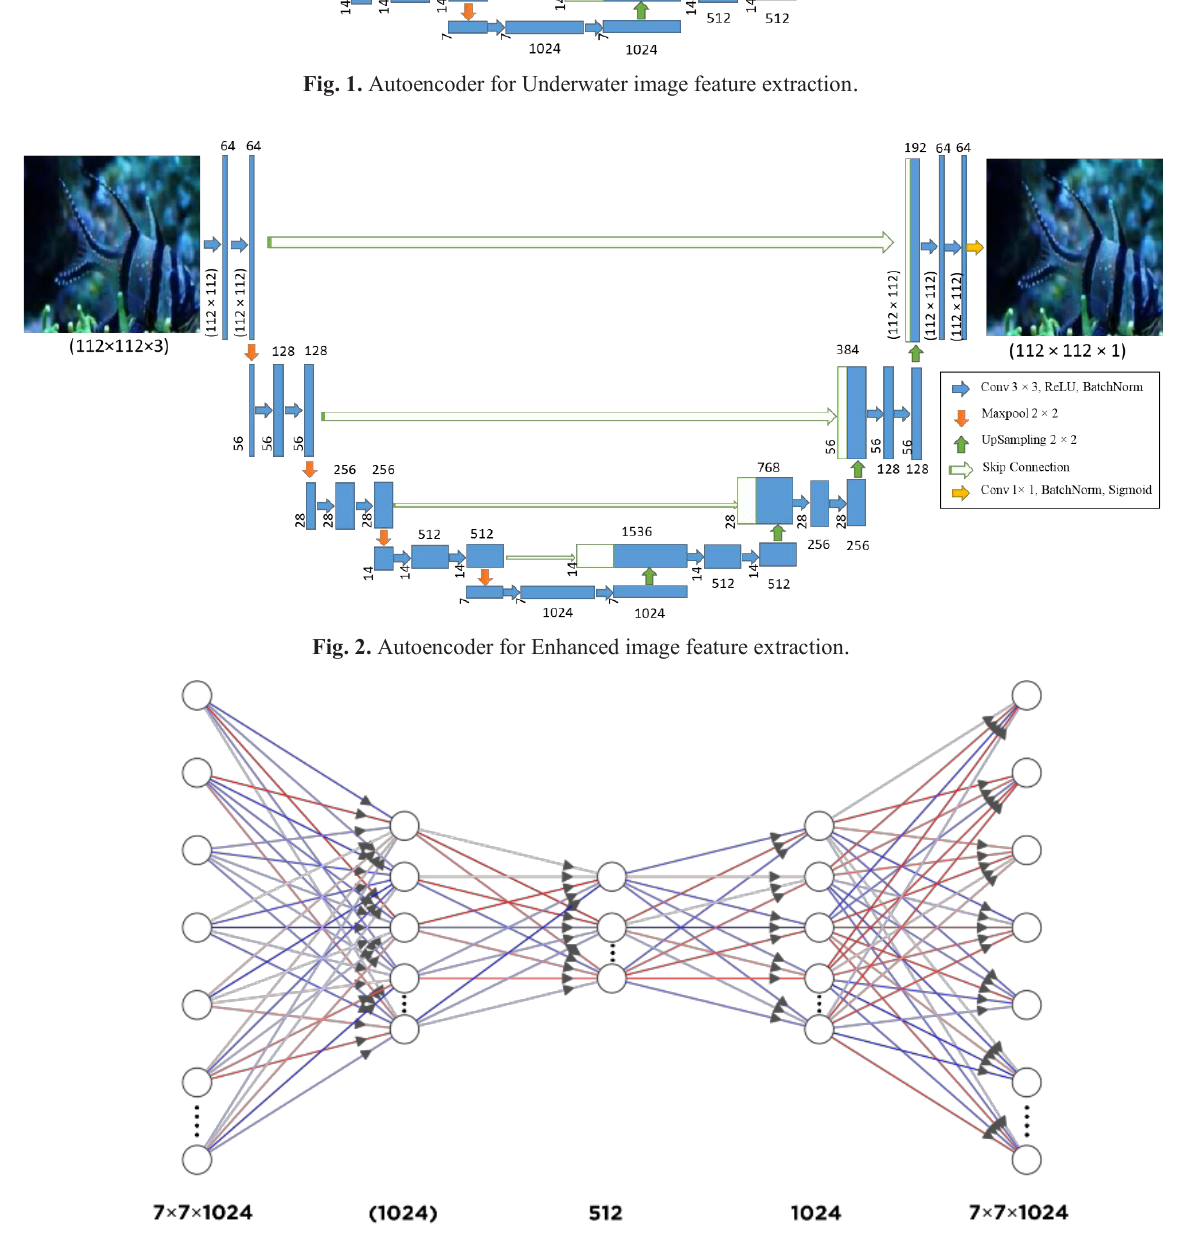
Fig. 3. Mapping Network